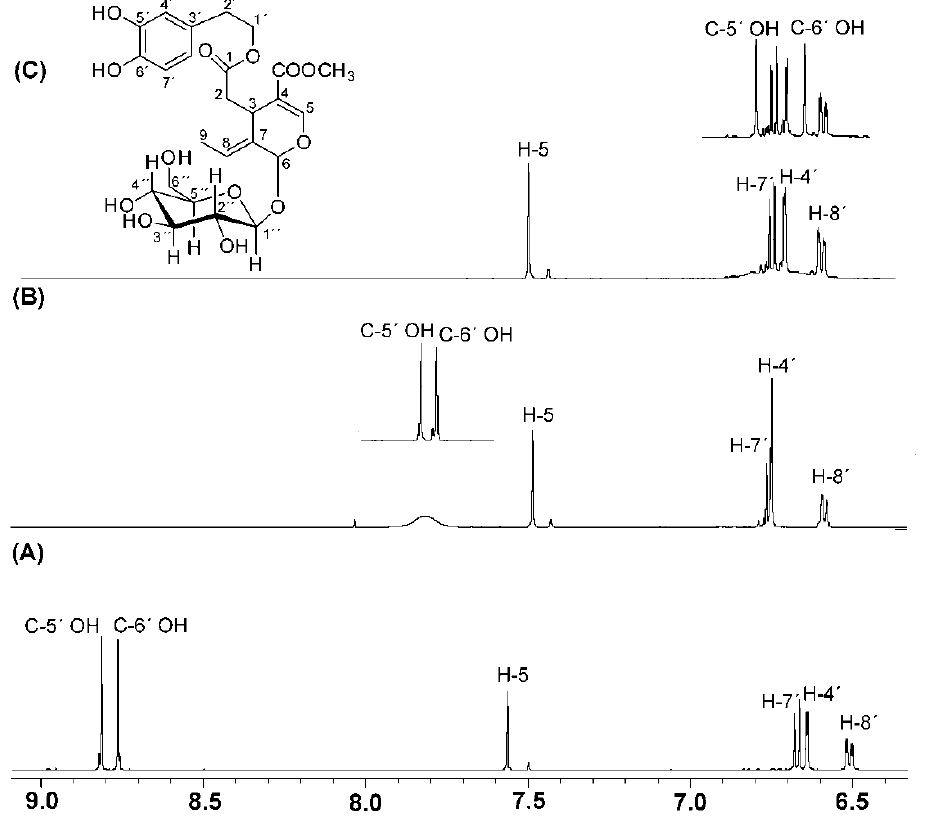
Figure 4. 1 H-NMR spectra (500 MHz) of oleuropein 6- O - β - D -glucopyranoside, concentration 5 mM (T = 292 K, number of scans = 64, experimental time = 8 min) in ( A ) DMSO- d ( B ) acetone- d , upper trace after the addition of 2 μL picric acid, 8 mM in acetone - d 6 and ( C ) CD CN, upper trace after the addition of 2 μL picric acid, 8 mM in CD 3 Reprinted with permission from [25]. Copyright 2013, The Royal Society of